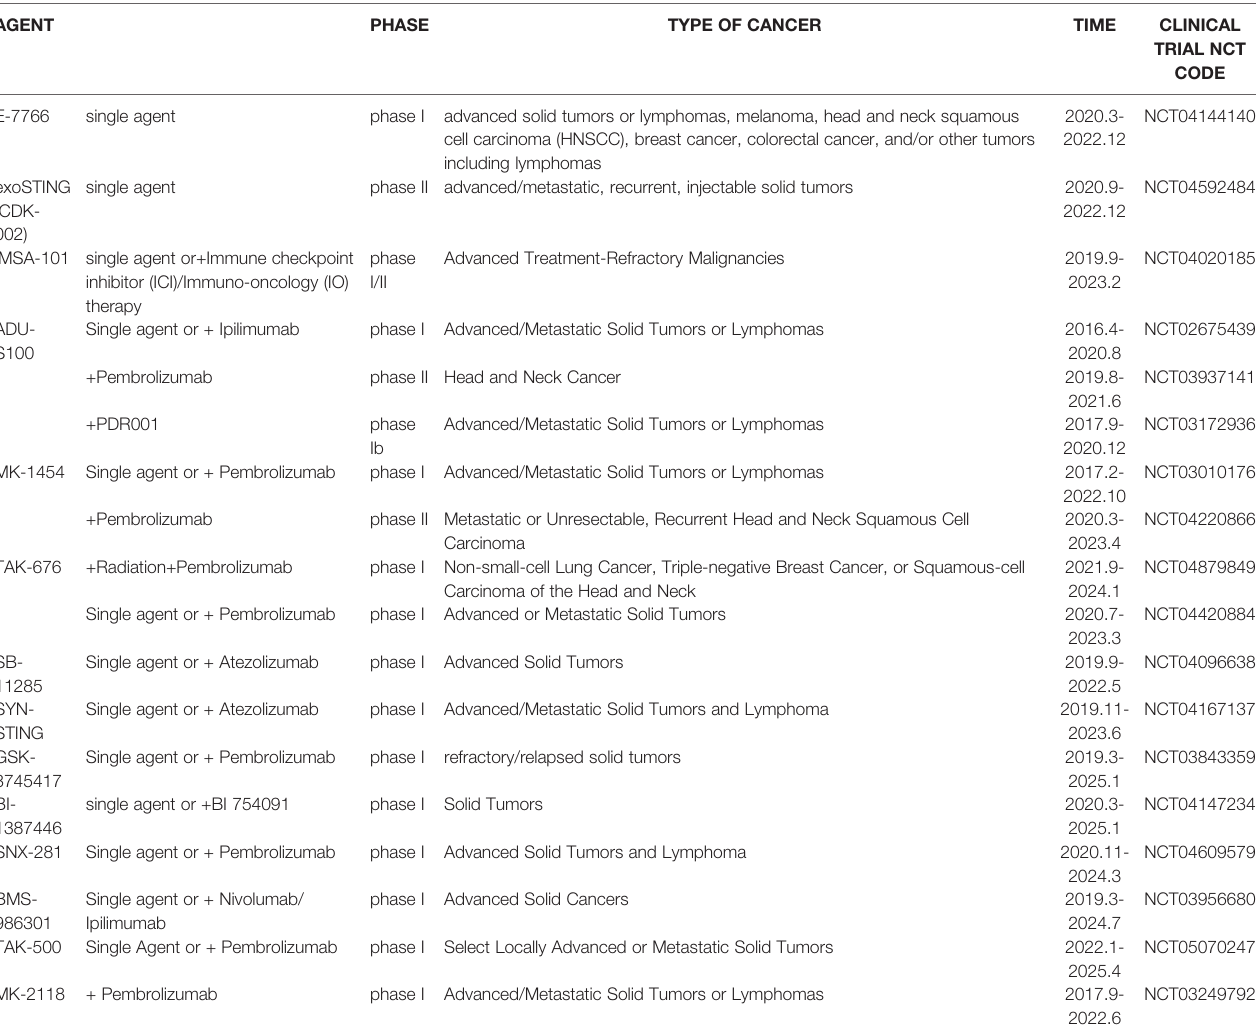
TABLE 3 | STING agonists in clinical